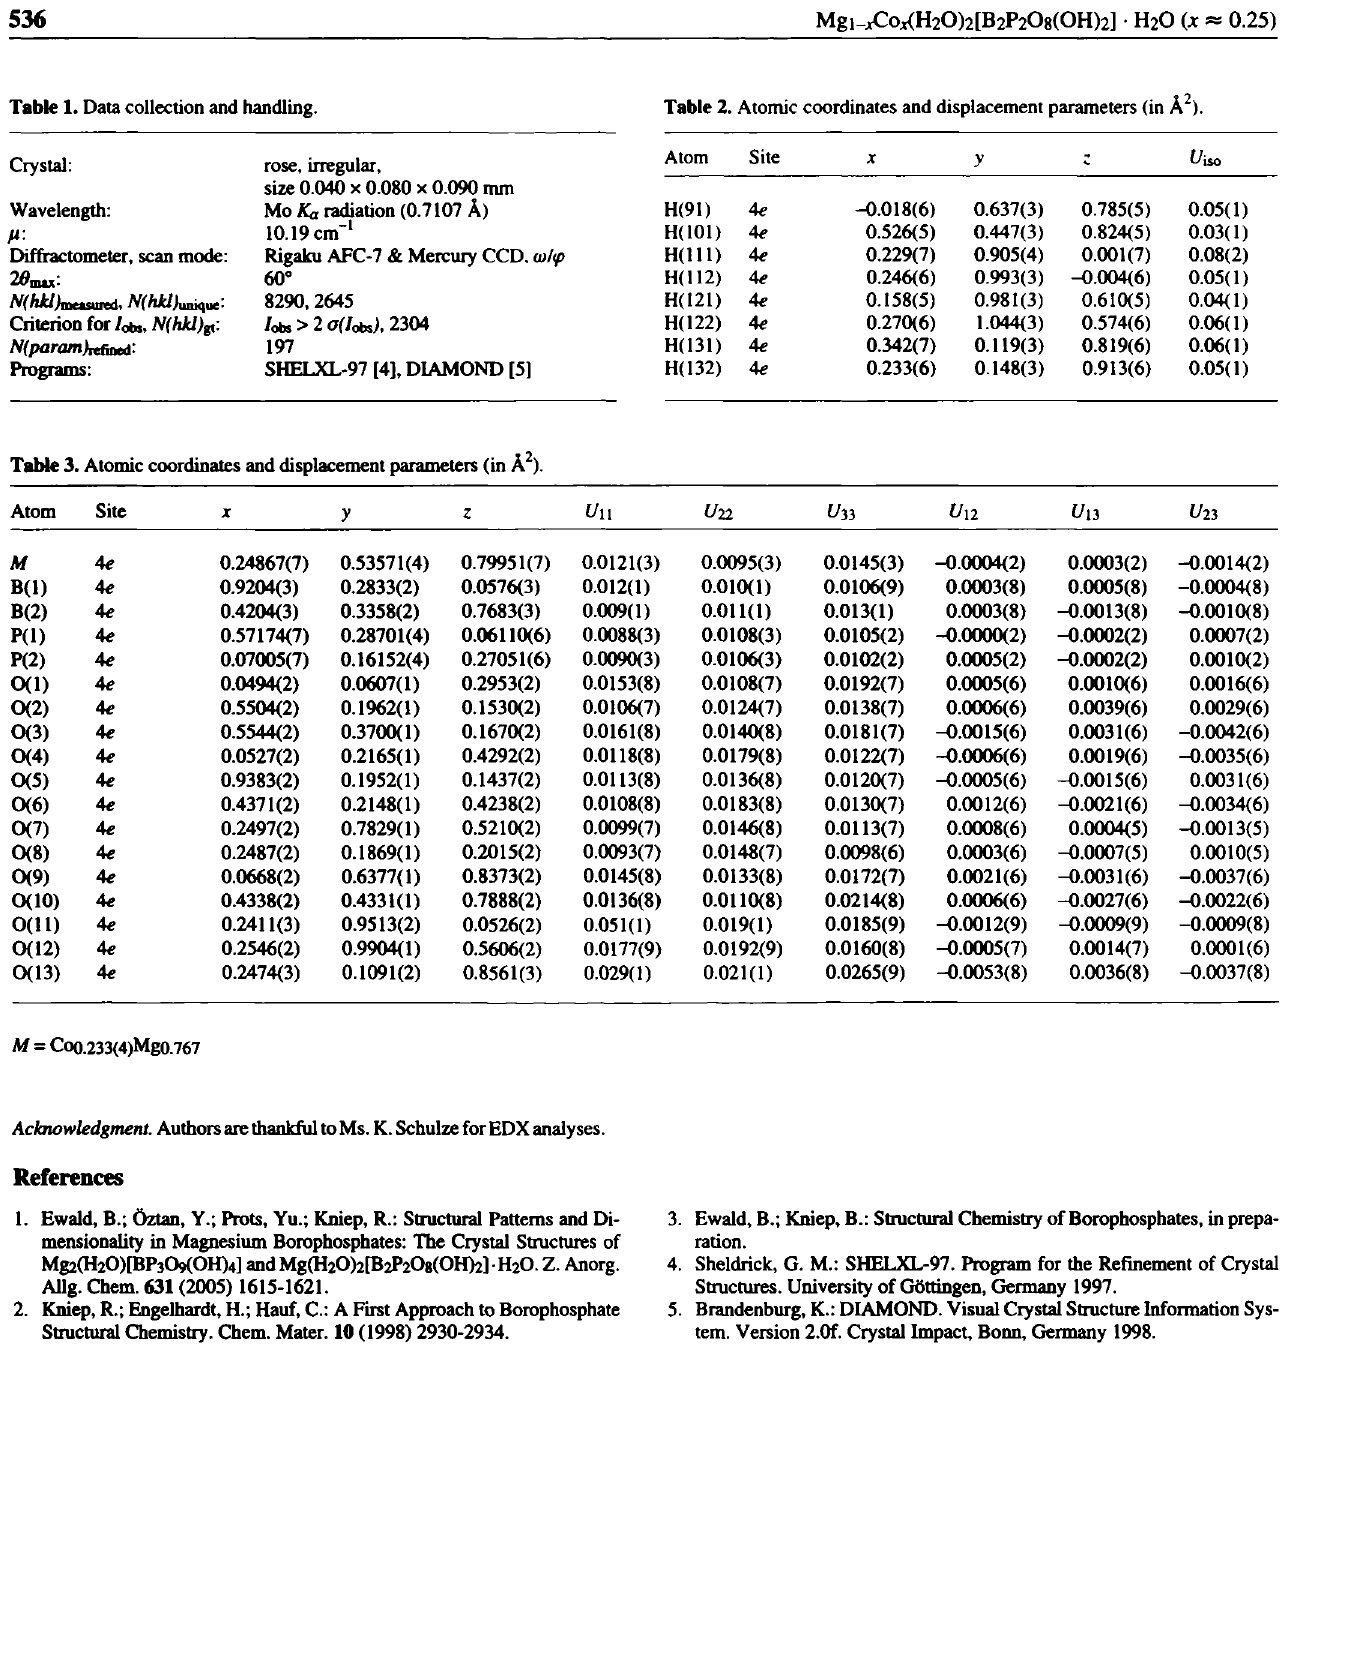
Table 3. Atomic coordinates and displacement parameters (in A 2